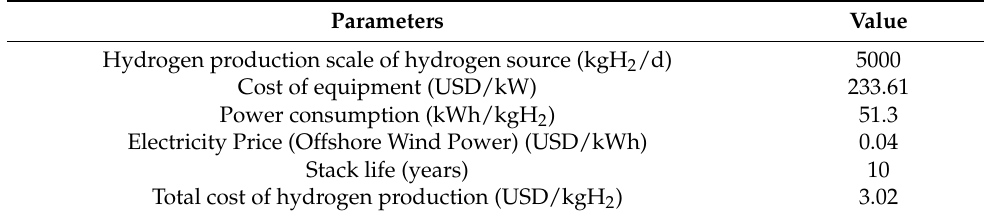
Table 7. Economic parameters of PEM and cost result.